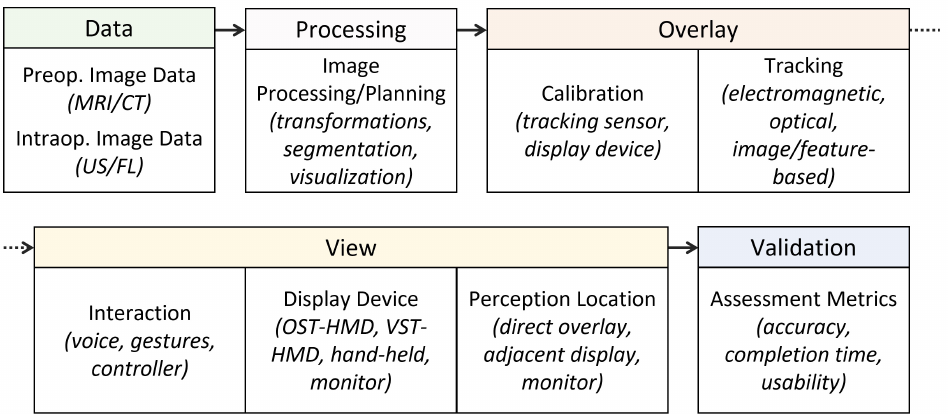
Figure 7. A taxonomy of the required components of an effective augmented reality based navigation solution for image guided surgery. Preoperative (preop.) data, such as magnetic resonance imaging (MRI) and computed tomography (CT), along with intraoperative (intraop.) data, such as ultrasound (US) and fluoroscopy (FL), are indicated. In the view category, the display device for visualization of virtual content is included, these could be optical see-through head-mounted displays (OST-HMDs) or video see-through head-mounted displays (VST-HMDs) for example. Our taxonomy is modified from the description provided by Kersten-Oertel et al.